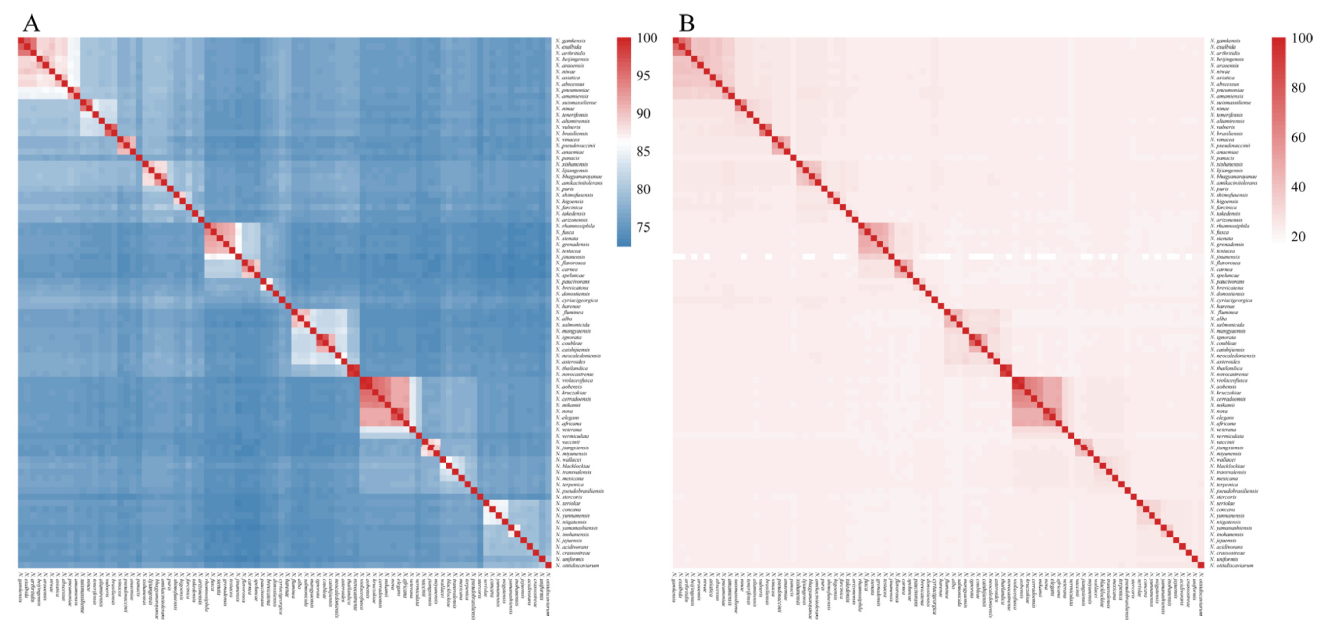
Fig 3. Heatmap of pairwise ANI and is DDH values for 86 type strains. (A) Species delineation at an ANI threshold of 96% and (B) is DDH threshold of 70%. The isolate names on the left are the same as those in Fig 2A with the outgroup removed. The values underlying this heatmap were provided in the S4 and S5 Tables.